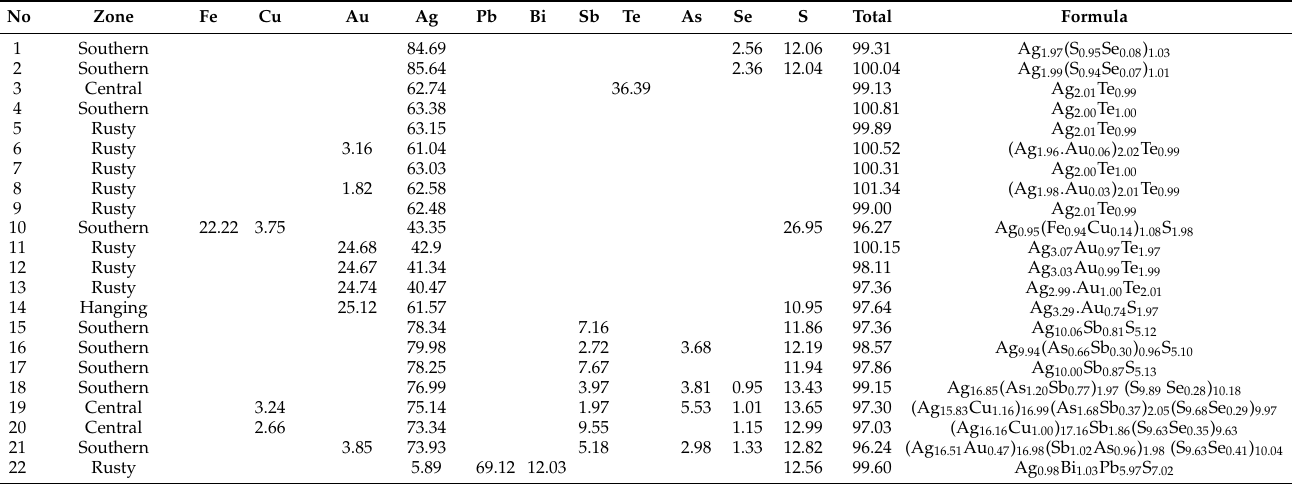
Table 4. Composition of Au-Ag minerals in the gold-pyrite-quartz association from various zones of the Baranyevskoe deposit, wt. %.